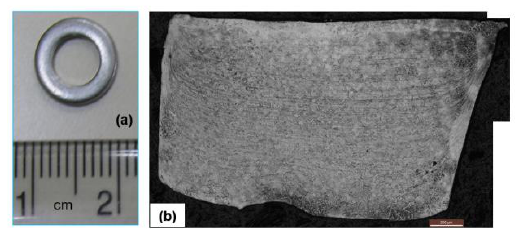
Figure 16: (a) As-received photograph of the plain washer of Figure 4a,c showing no sign of corrosion, (b) optical micrograph of the whole cross-section with no trace of corrosion, etchant: aqua-regia.